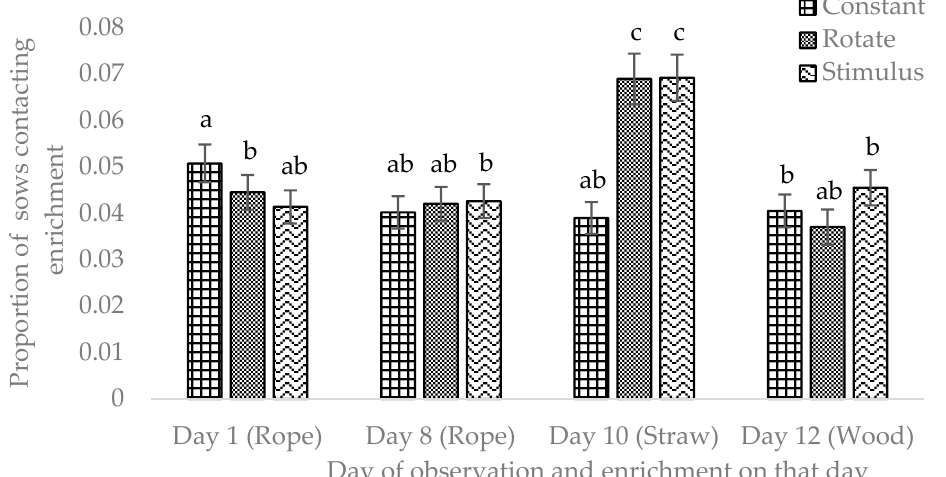
Figure 5. Proportion of sows contacting enrichments (rope, wood or straw) and day of observation (days 1, 8, 10 and 12) in the Constant, Rotate and Stimulus treatments. Note: sows in the Constant treatment received the wood enrichment on all days. Sows were observed during an 8-h period (8:00–16:00 h) on four days (1, 8, 10 and 12) using time lapse photos taken at 10-min intervals ( n = 46, F = 7.72, p < 0.001). a,b,c Bars without a common superscript are significantly different at p <